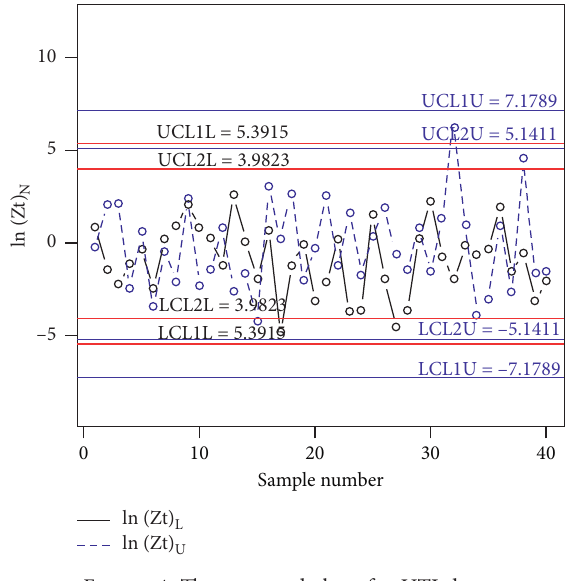
Figure 4: The proposed chart for UTI data.